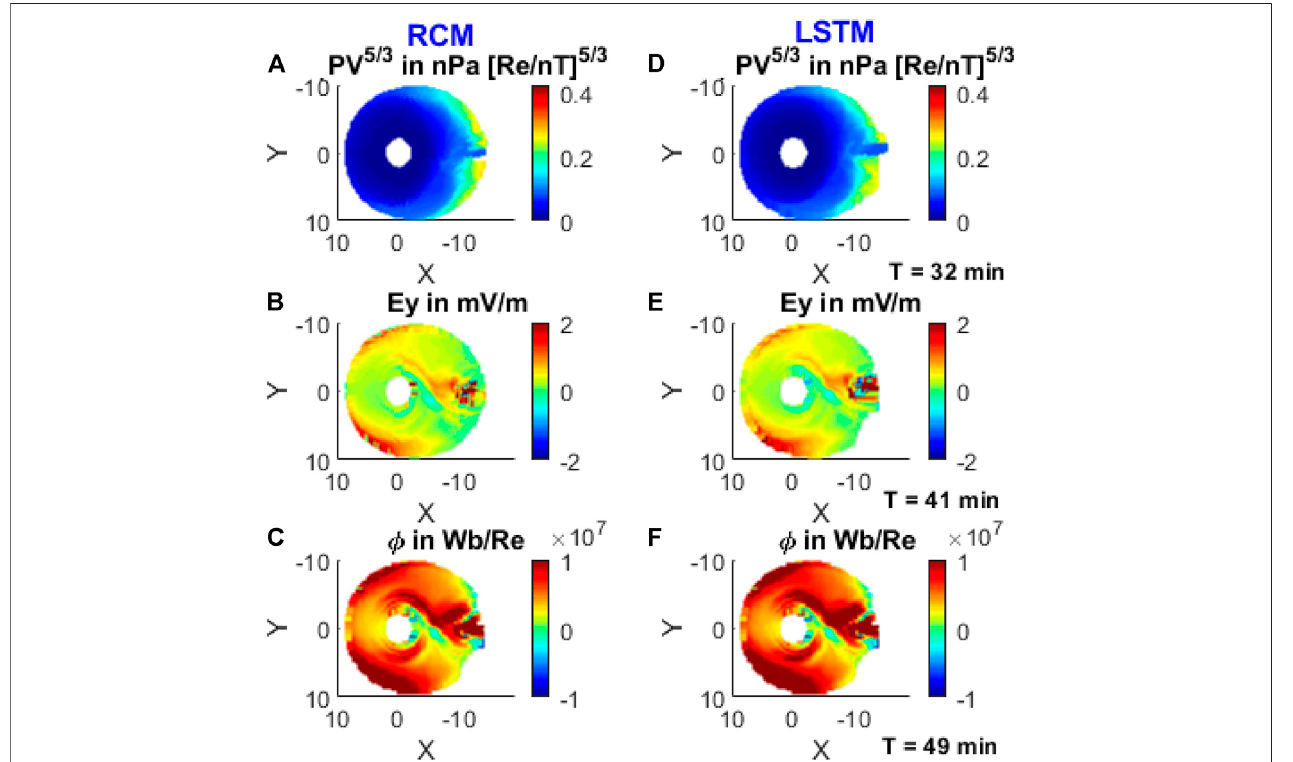
FIGURE10| FromtoptobottomarecomparisonoftheRCMandLSTMforecastsduringthesingle- fl ow-channelrunforPV 5/3 at T (cid:1) 32 min,E y at T (cid:1) 41 min,and ϕ at T (cid:1) 49 min.